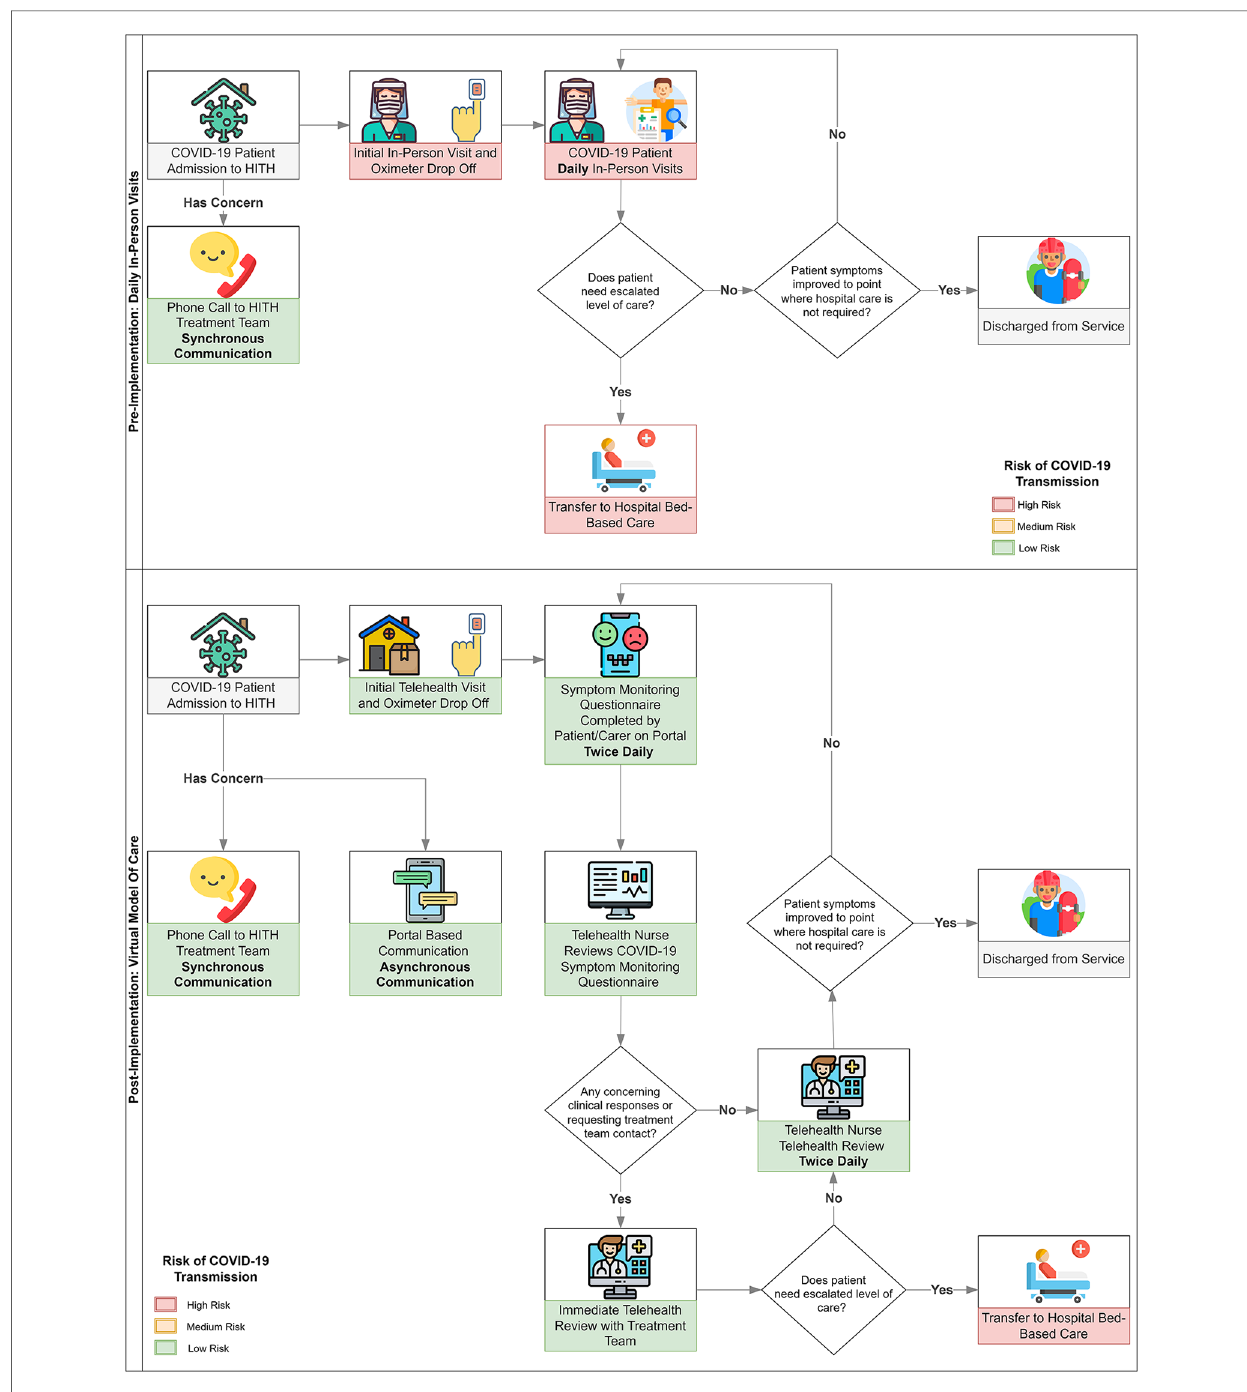
FIGURE 1 Pre and Post Virtual HITH COVID-19